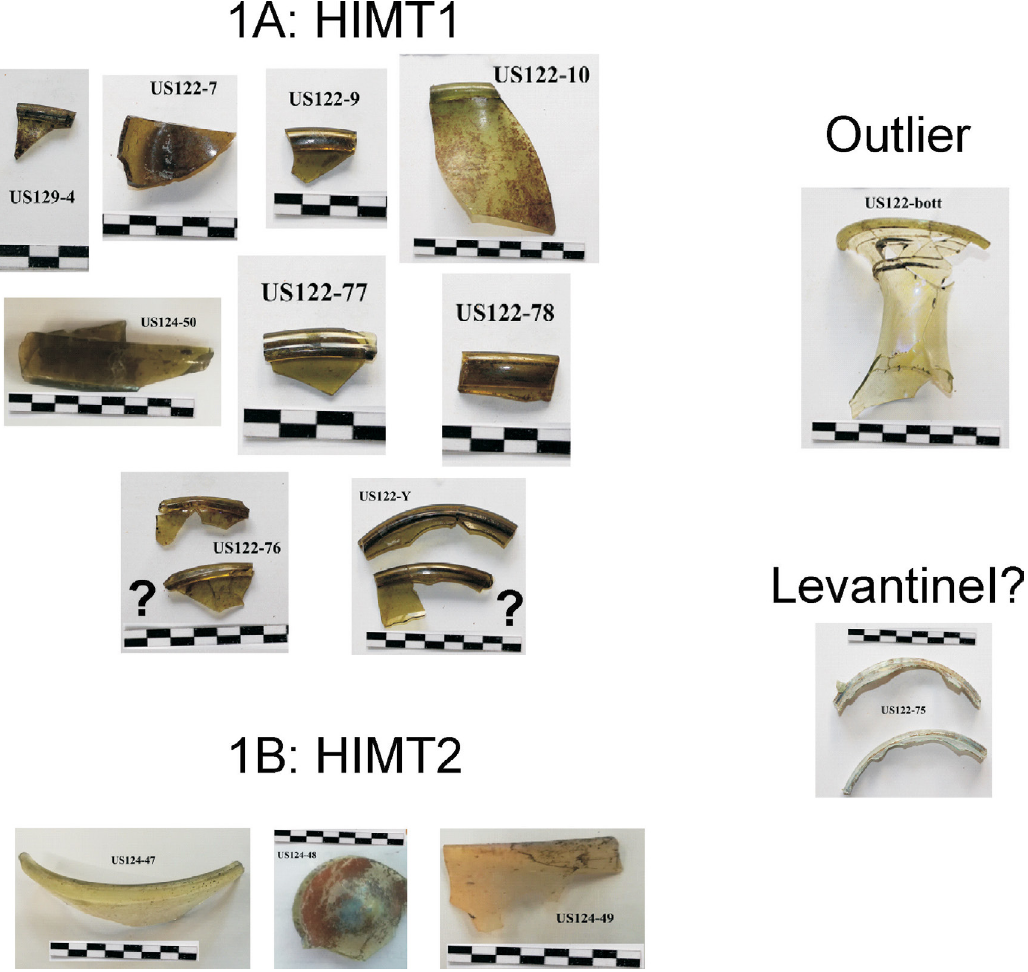
Figure 2: Vitreous finds of the first group dated to the 4 th –6 th century